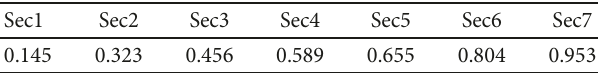
Table 3: The span sections ( y / b ). Table 4: The grid